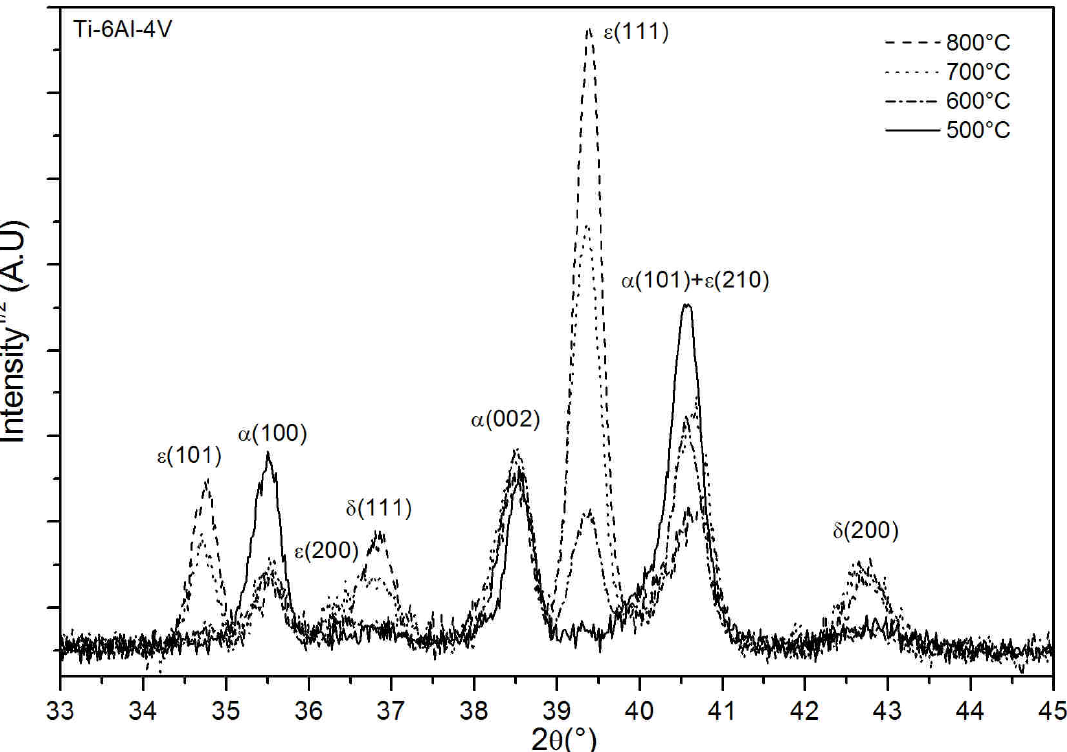
Figure 1. X-ray diffraction results with incidence angle of 5° performed on Ti-6Al-4V specimens treated with PBII (25 kV, 200 Hz, 10 µs) for 240 min at either 500, 600, 700 or 800 °C in a mixture of 90% N 2 –10% H 2 at 1 Pa.